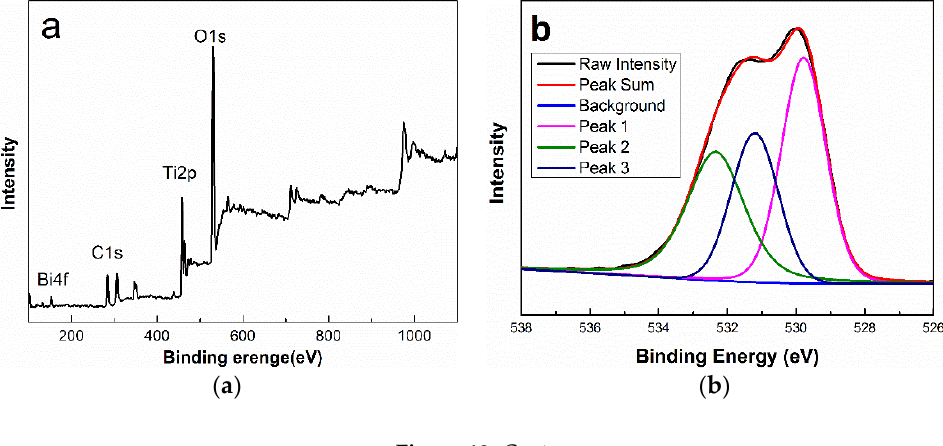
Figure 9. The percentage distribution of Bi 3+ ions ( a ), SPA ( b ) species, Ti 4+ ions ( c ) and Pb 2+ ions ( d ) as a function of pH values.